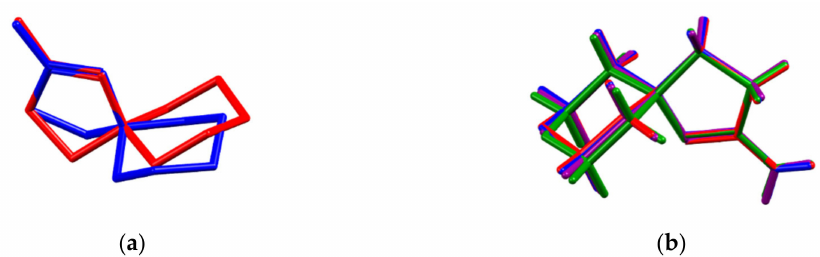
Figure 2. Molecular conformations of ( a ) two independent cations in 5d (blue and red; H atoms are omitted); ( b ) similar conformations of cations in 5c (red), 5d (blue), 5e (green) and 6